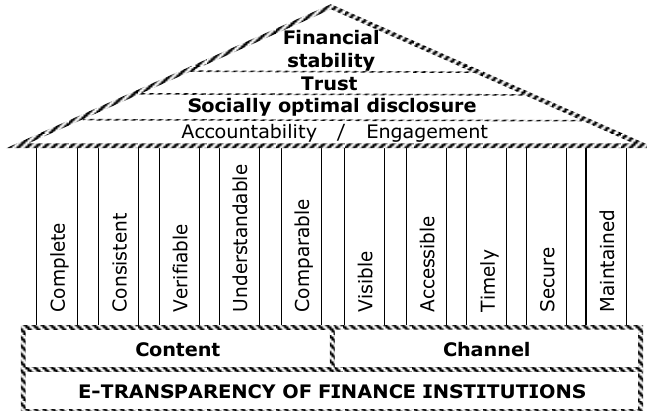
Fig. 1. The concept of e-transparency of finance